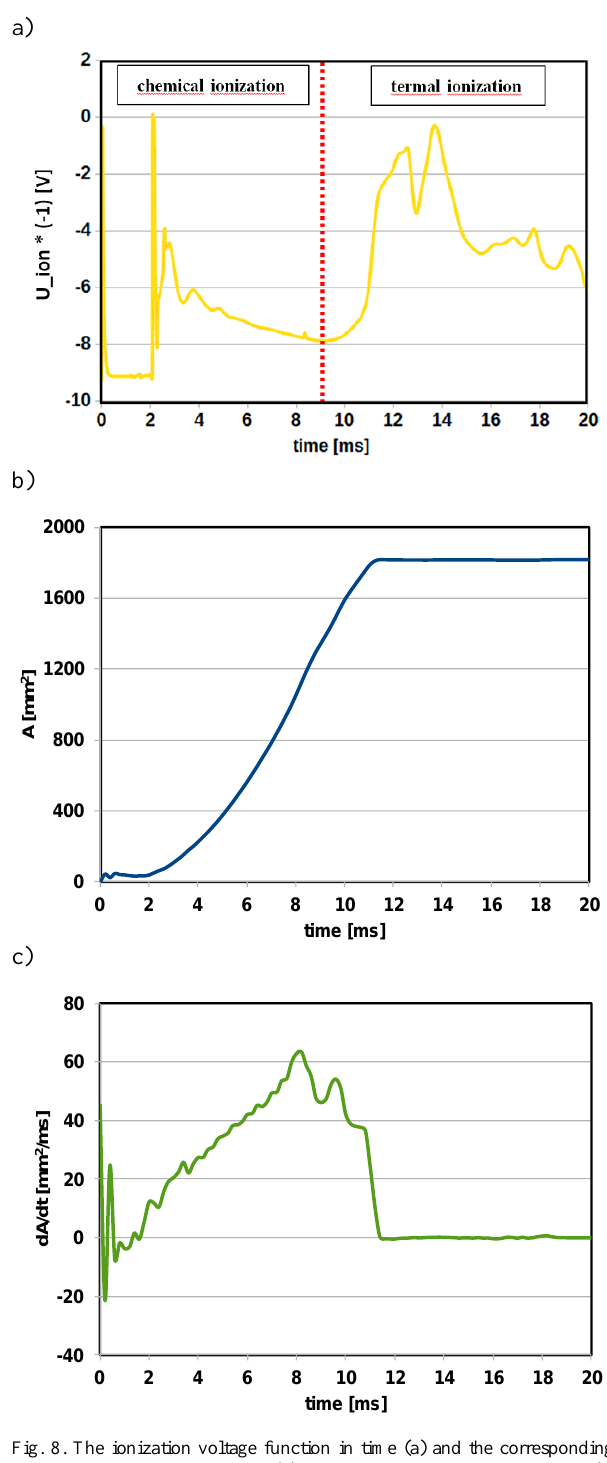
Fig. 8. The ionization voltage function in time (a) and the corresponding waveforms of the flame surface (b) and the speed of flame propagation (c) for a single RCM operating point